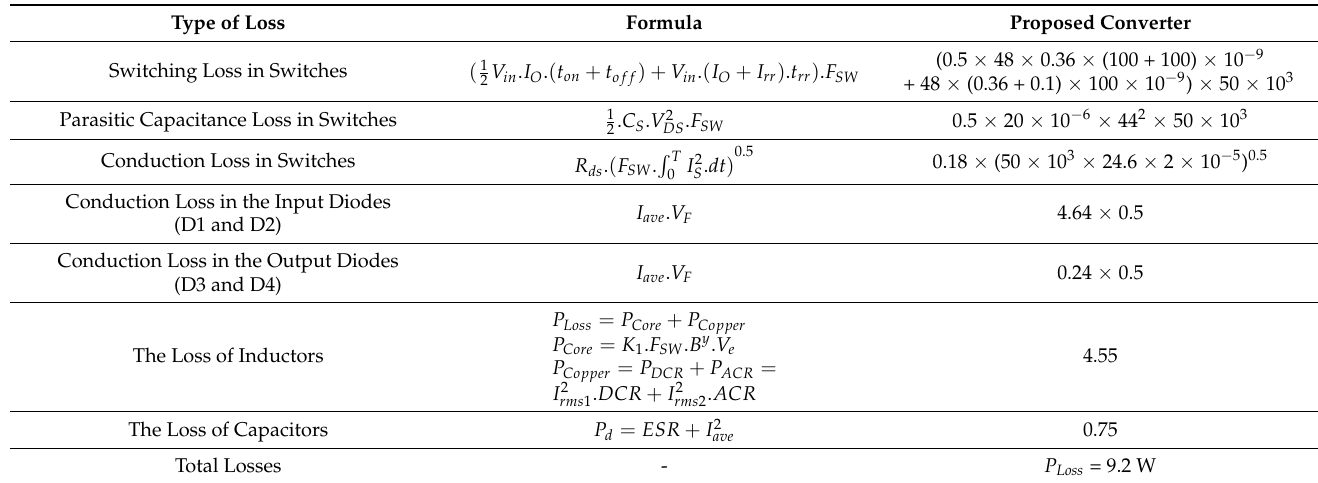
Table 3. Power losses of high step-up three-level soft switching DC-DC